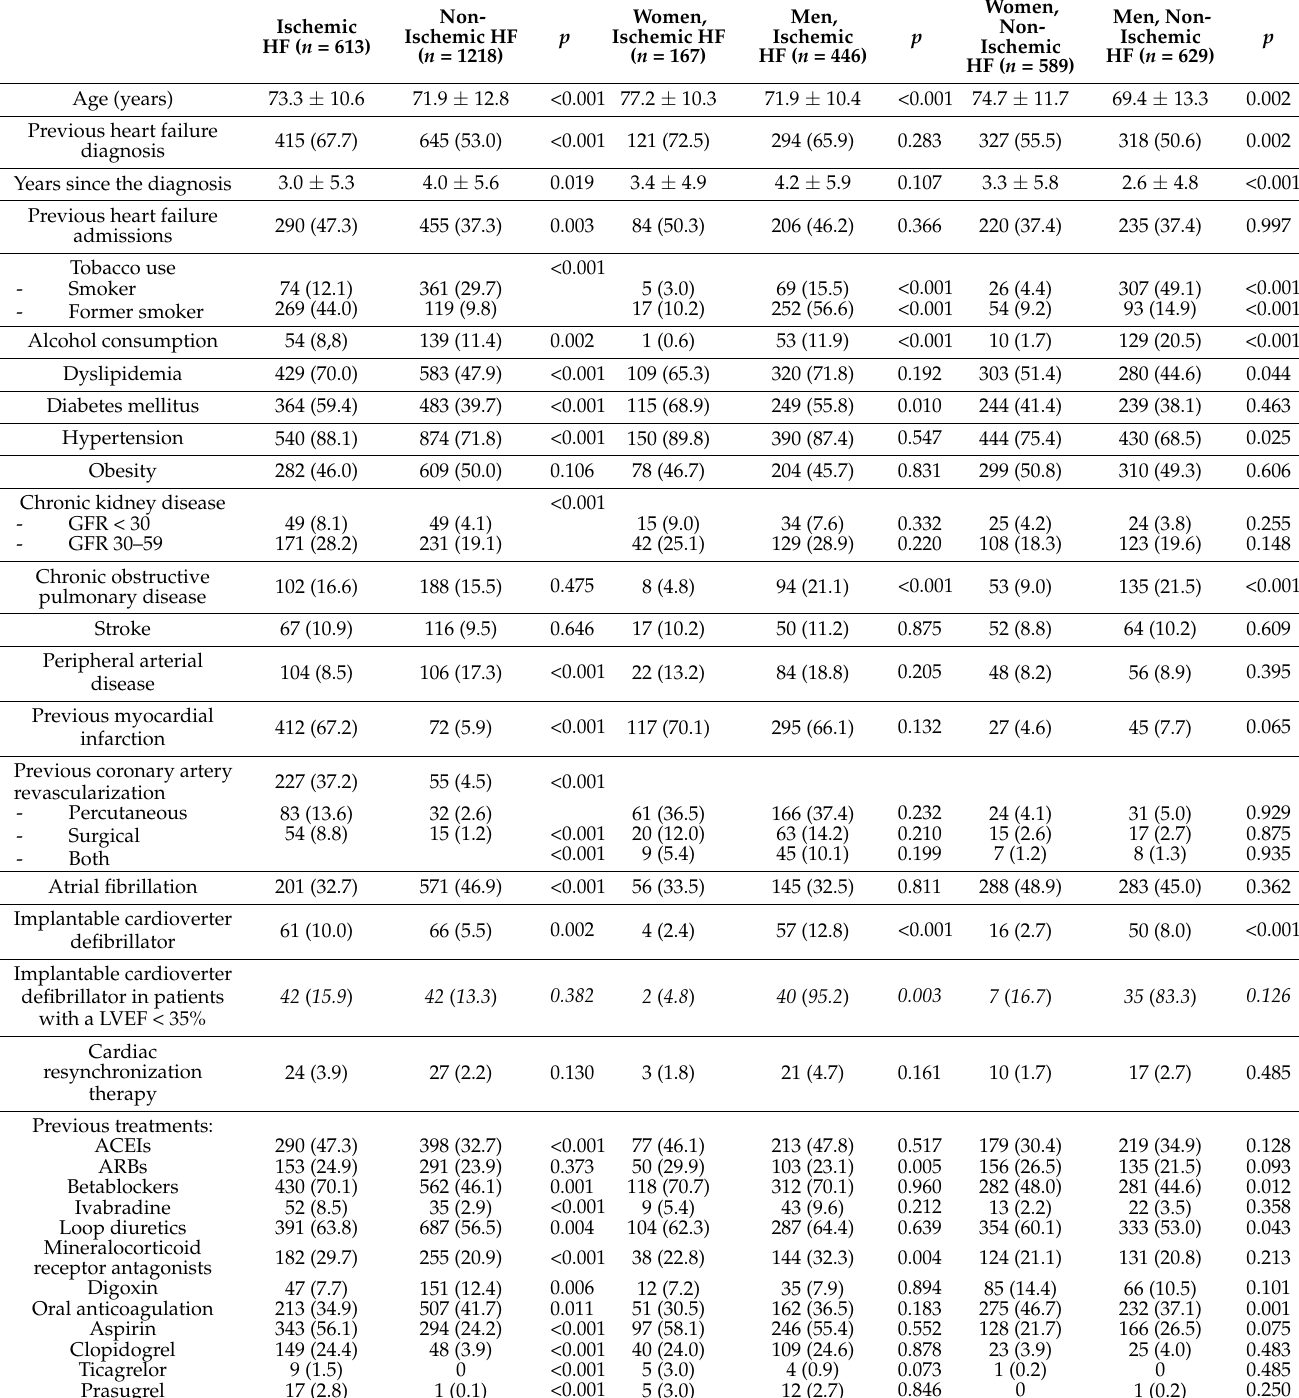
Table 1. Baseline characteristics in patients admitted with heart failure (HF) according to etiology and sex. Non- Women, Ischemic p Ischemic HF Ischemic HF HF ( n = 613) ( n = 1218) ( n =